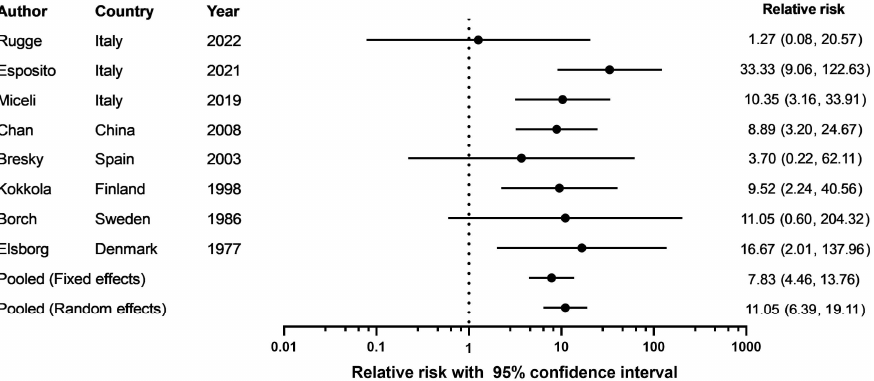
Figure 2. Gastric cancer relative risk of the eight studies with active follow-up in AMAG patients [9–11,13–16,18].